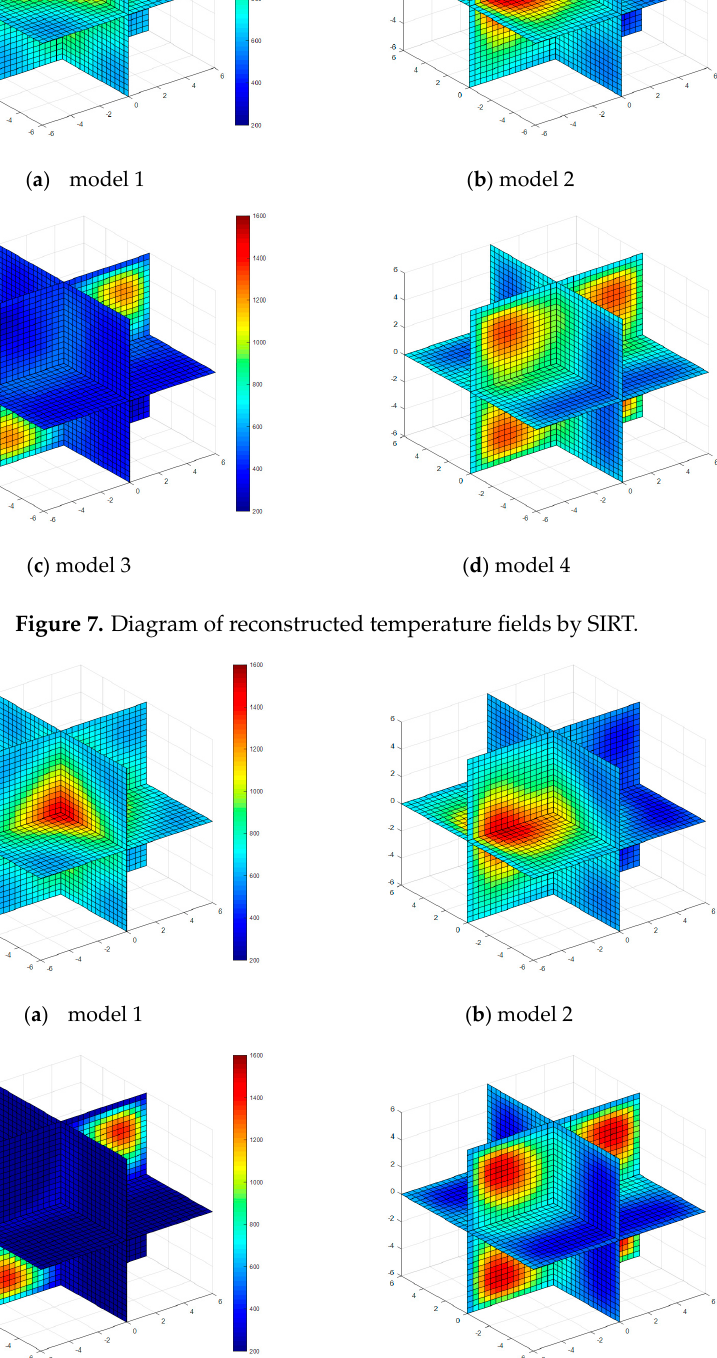
Figure 8. Diagram of reconstructed temperature fields by dynamic reconstruction algorithm. Three kinds of errors, namely the maximum relative error and the root mean square error 3 E are adopted to evaluate the reconstruction results of the five algorithms. The errors are defined as (29)–(31) respectively.